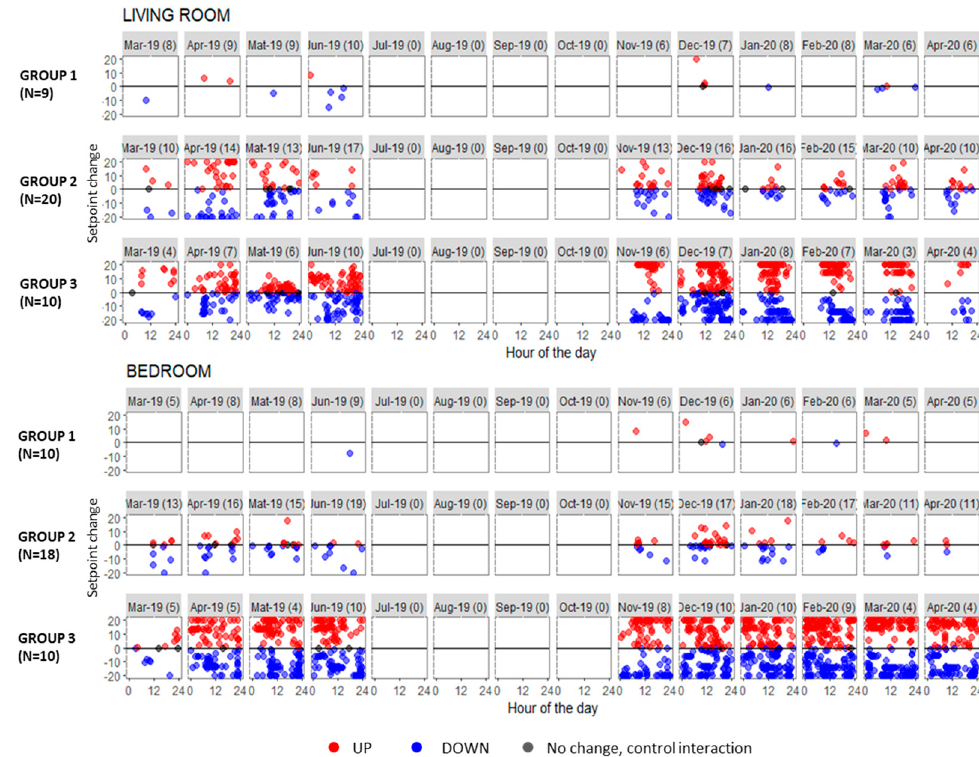
Figure 4. Observed interactions with STVs across months by hour of the day (x-axis) and type of interaction (y-axis). The number of flats that recorded data within each group is shown in brackets. Monitoring started on 15 March 2019 and ended on 30 April 2020. Between July and October 2019, no data were recorded because the communication system was not functioning. Table 2. Summary of groups’ main characteristics for the monitoring period March 2019 to April 2020. Summary statistics were obtained by weighting the observations by the number of total observations in each flat. In the case of non-normal distributions, the median is indicated instead of the